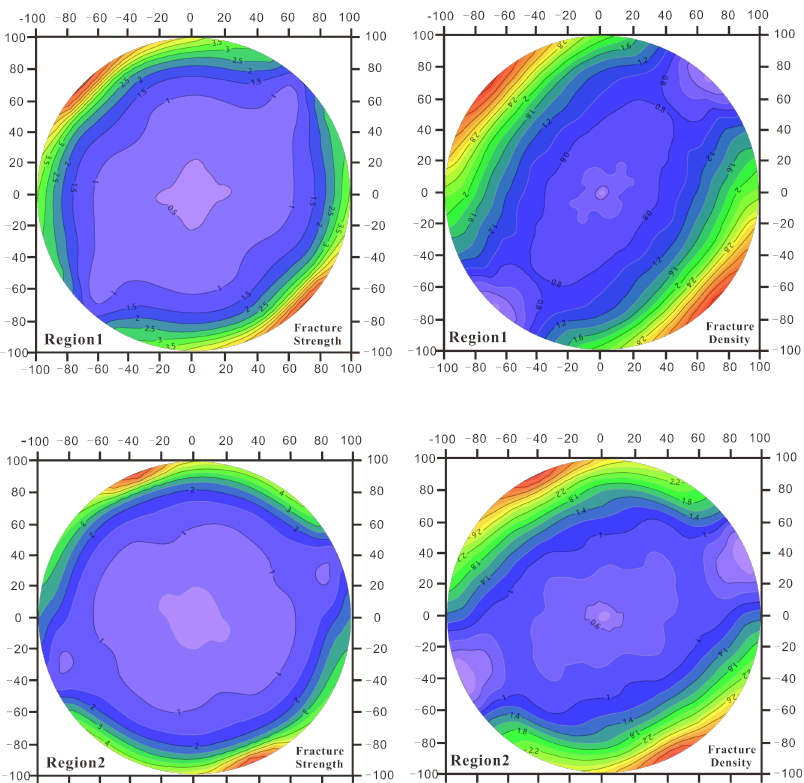
Figure 20. Semi-variance contour map of the fracture strength and fracture density of lineaments in study area 1 and study area 2 extracted by the improved line segment tracking method. Table 3. Three sets of data for fracture strike and fracture tendency.